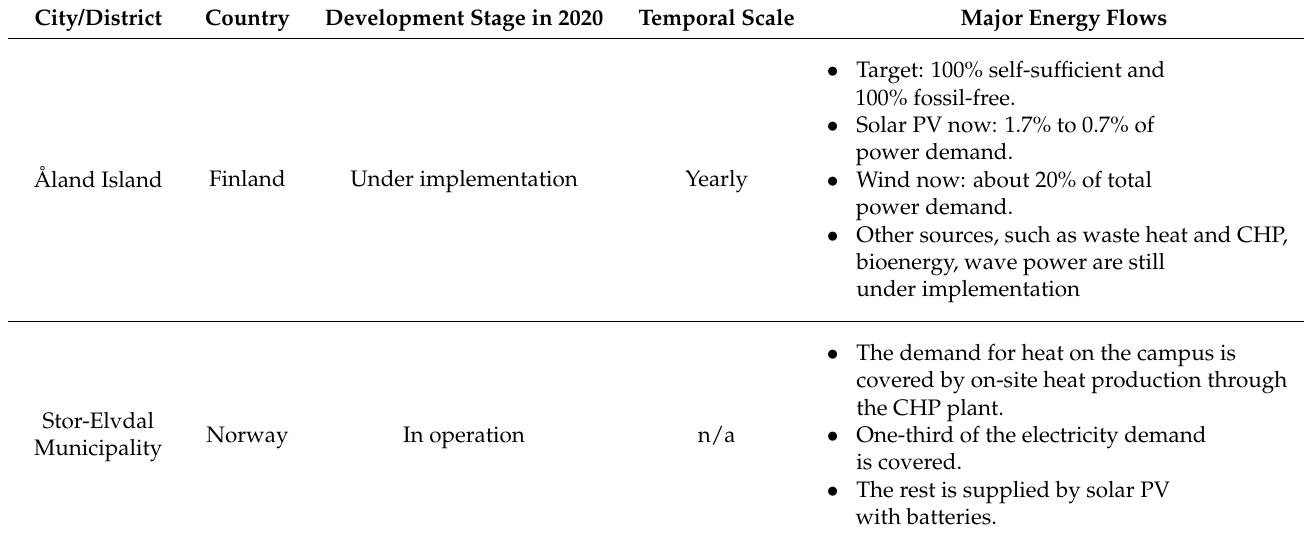
Table 4. Summary of major energy concepts and flows of a few PED